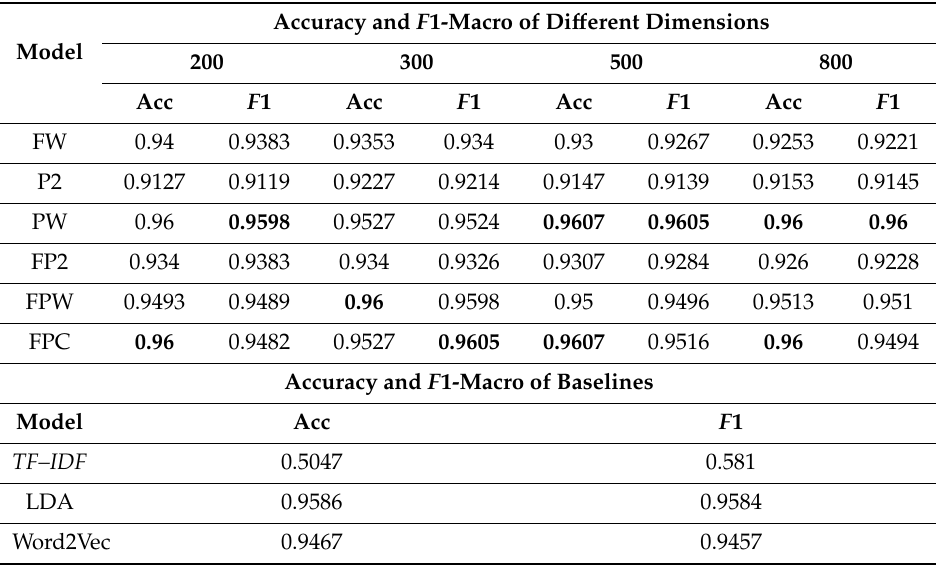
Table 5. Results of FudanNLP in three classes for 1500 texts by KNN.